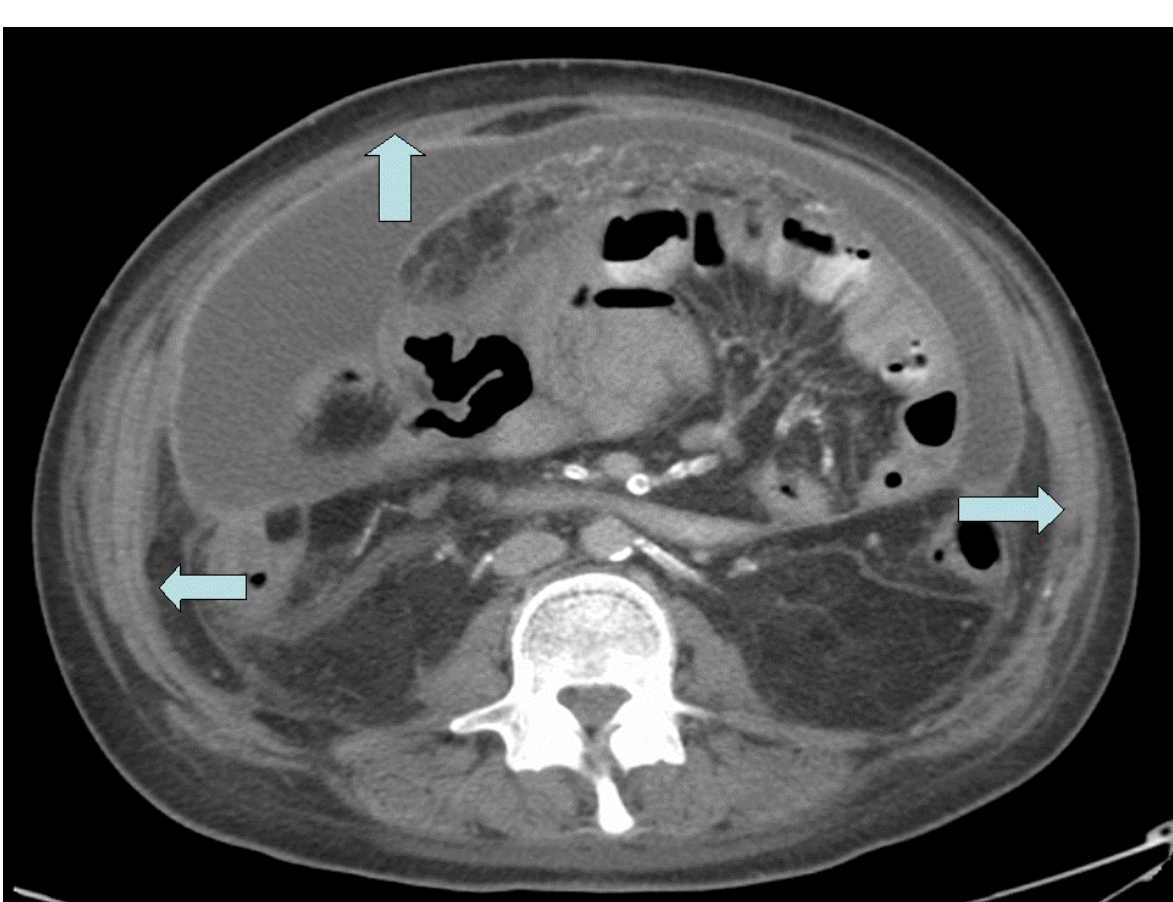
FIGURE . CT image of the abdomen shows dilated small bowel loops surrounded by thickened fibrous